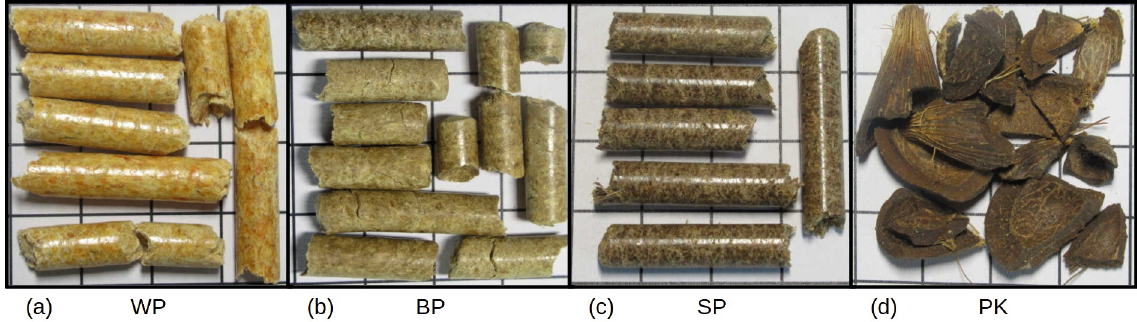
Figure 3. Fuels used in the experiments; ( a ) Wood pellets; ( b ) Bamboo pellets; ( c ) Wheat straw pellets; ( d ) Palm kernel shells; edge length of a box is 1 cm.